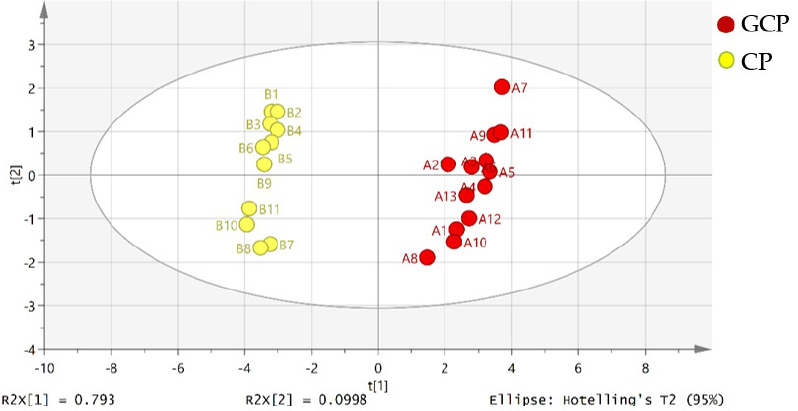
Figure 5. Score plot of the principal component analysis (PCA) of Guangchenpi (Group A) and Chenpi (Group B) samples. Red circles represent GCP samples, and yellow circles represent GCP samples.